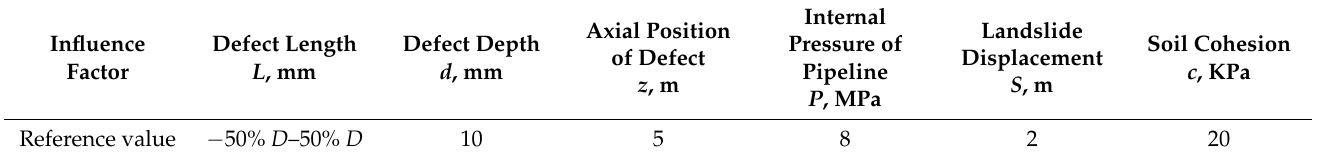
Table 5. Model parameters for varying defect length.